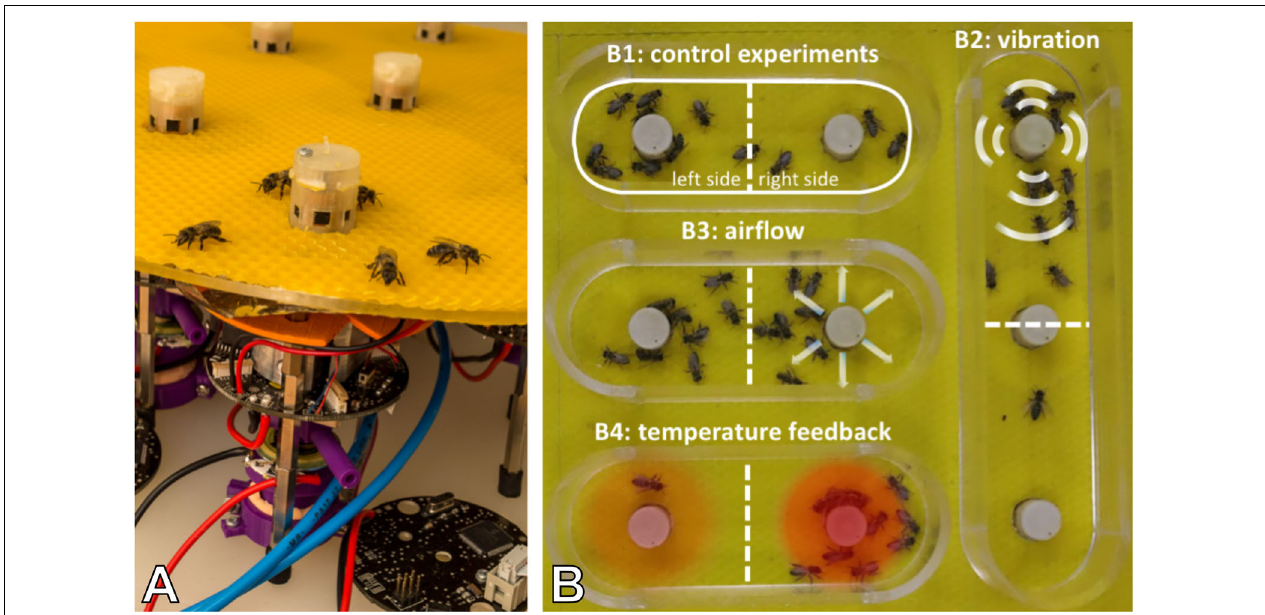
FIGURE 6 | Combined actuator sensor unit (CASU) for bees developed in the project ASSISI_bf and experimental set-ups. (A) CASUs with surrounding honeybees: above the arena floor, which is covered with beeswax sheets, is the cylindrical top part that houses the six infrared sensors for bee detection (sensing radius approximately 2 cm) and the airflow nozzles. Below the arena floor is the bottom part of the CASU with the heat-exchange and vibration devices and the air pipes (single-board computers connected to the CASUs not shown). (B) Experimental set-up for testing (B1) the natural symmetry breaking in collective decision making of bees in constant temperature fields, (B2) symmetry breaking in collective decision making induced by vibration, (B3) collective decision making modulated by airflows, and (B4) the effect of robot-induced feedbacks on the symmetry breaking in collective decision making. Solid white line represents the evaluation area for counting the bees, divided by the dashed line (left side and right